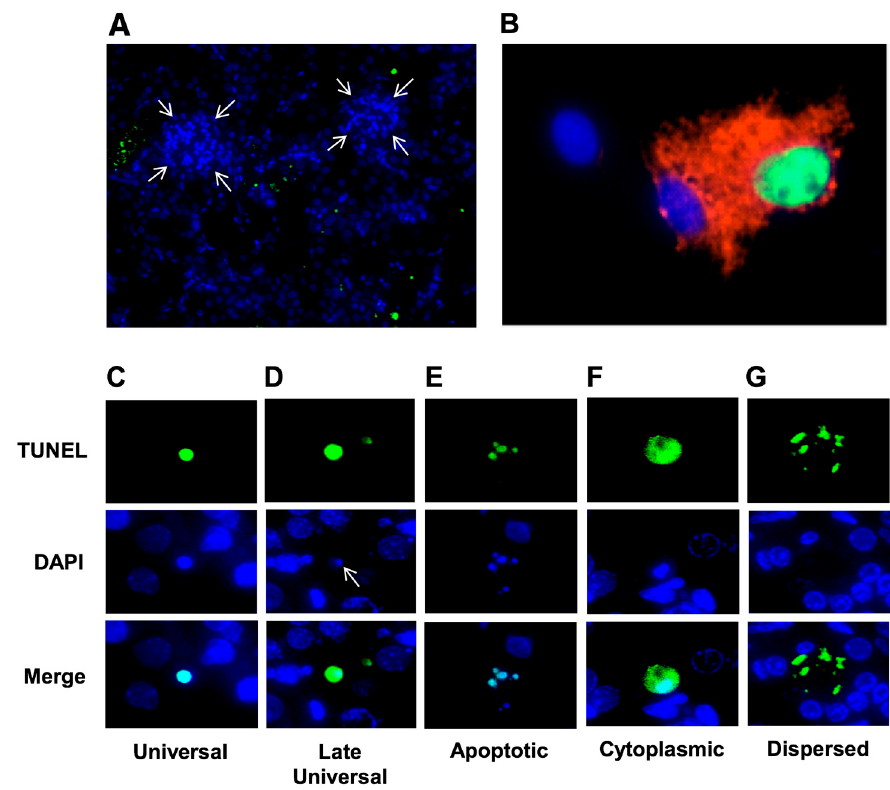
Figure 3. Variations of TUNEL images in kidneys of mice subjected to cisplatin injury (20 mg/kg, 4 days after exposure). ( A ) TUNEL image in kidney at low magnification; note poor TUNEL staining of glomeruli (shown by arrows) vs. tubules. ( B ) TUNEL-IHC combination; red staining indicates heme oxygenase 1 (HO-1) induced in two cells, one of which is TUNEL-positive (dead). ( C ) Commonly seen universal TUNEL signal indicative of any kind of cell death. ( D ) Late universal TUNEL signal with low DAPI staining of completely degraded DNA. ( E ) Apoptotic TUNEL signal; TUNEL staining of apoptotic bodies characteristic of apoptosis. ( F ) Cytoplasmic TUNEL signal that illustrates at least partial necrosis. ( G ) Necrotic dispersed TUNEL signal characterized by nuclear and plasma membrane lysis and irregular leakage of TUNEL-positive material from nucleus and cytoplasm. See Table 1 for a detailed description of TUNEL patterns shown in panels C through